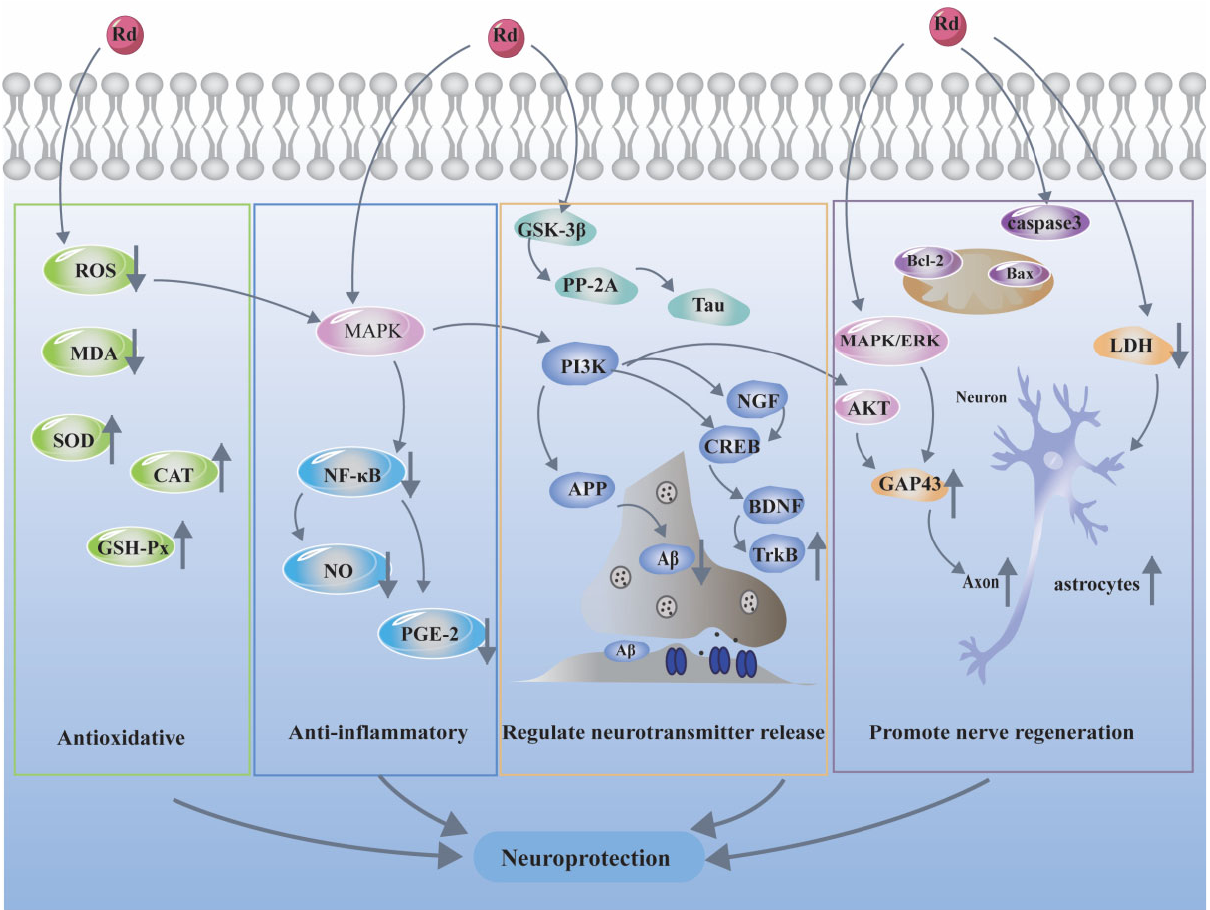
Figure 4. Neuroprotective mechanism of ginsenoside Rd. “ ↓ ” means downregulation, “ ↑ ” means upregulation.